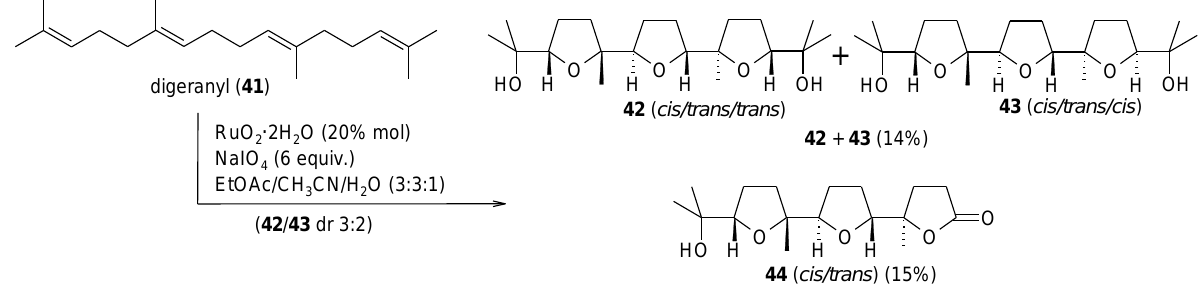
Figure 2. Head-to-tail type isoprenoid polyenes and digeranyl compared [104]. R H DigeranylSqualene ( E , E )-Farnesyl acetate Geranylgeranyl acetate